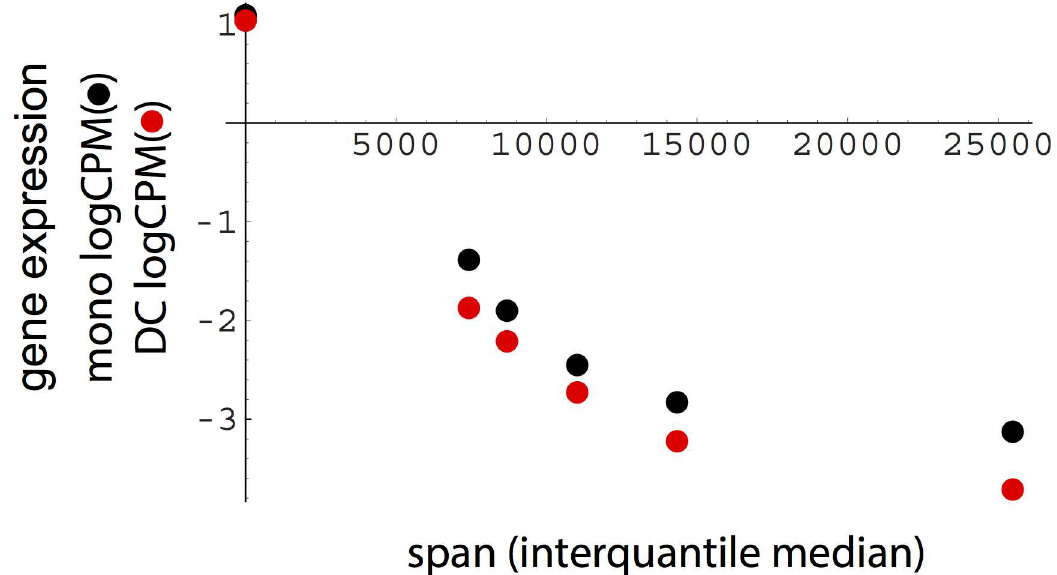
Fig 2. Association of PcG region span with reduced RNA levels. For both monocytes and dendritic cells (DC), expression (RNA- seq log counts per million) exhibited a strong negative correlation with the span of overlapping regions. Points designate no PcG region overlap (y-axis), or median span values (from left to right, quantile ranges: 0–0.25, 0–0.5, 0.25–0.75, 0.5–1, 0.75–1). Monocyte comparison for quantiles 0–0.25 vs. 0.75–1, p < 6.9 10 −12 , Wilcox test. DC comparison for quantiles 0–0.25 vs. 0.75–1, p < 3.1 10 −14 , Wilcox